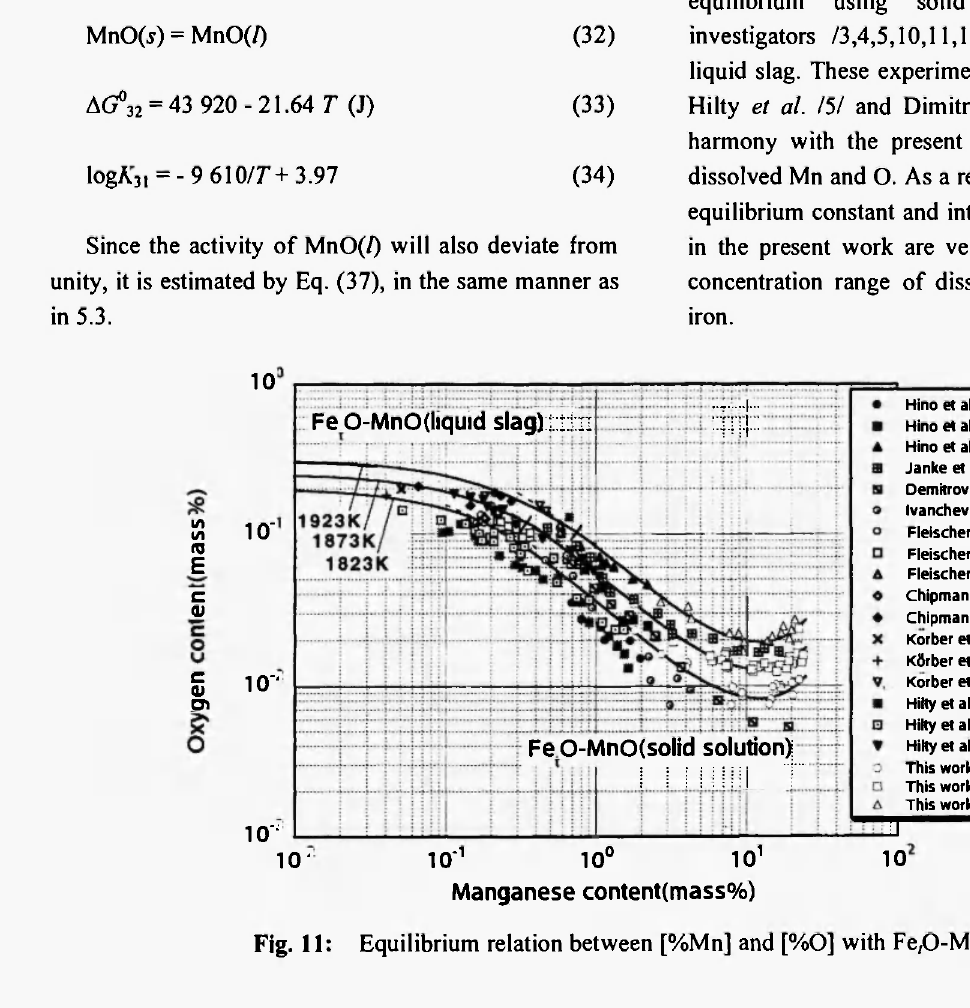
MnO(/) = Μη + Ο MnO(s) = MnO(/) AG 0 32 = 43 920-21.64 Τ (J) log/k3i = - 9 610/Γ + 3.97 Since the activity of MnO(/) will also deviate from unity, it is estimated by Eq. (37), in the same manner as in 5.3.